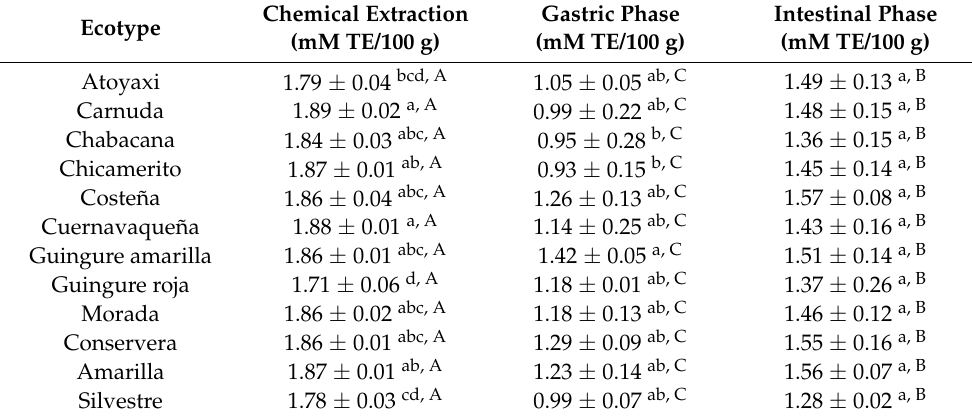
Table 8. Antioxidant capacity by DPPH of 12 ecotypes of S. purpurea L. before and after in vitro